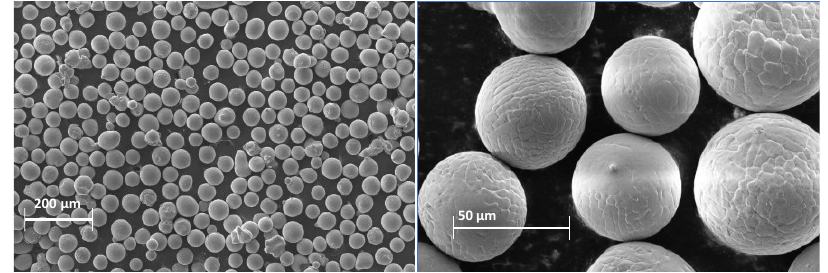
Fig. 1. SEM BSE image of Al 1070-B5 powder, at different